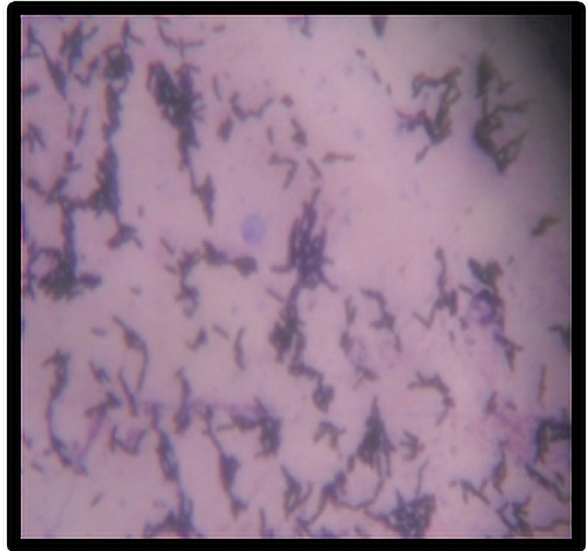
Fig 1. Gram stain of the selected Bacillus strain showing gram-positive